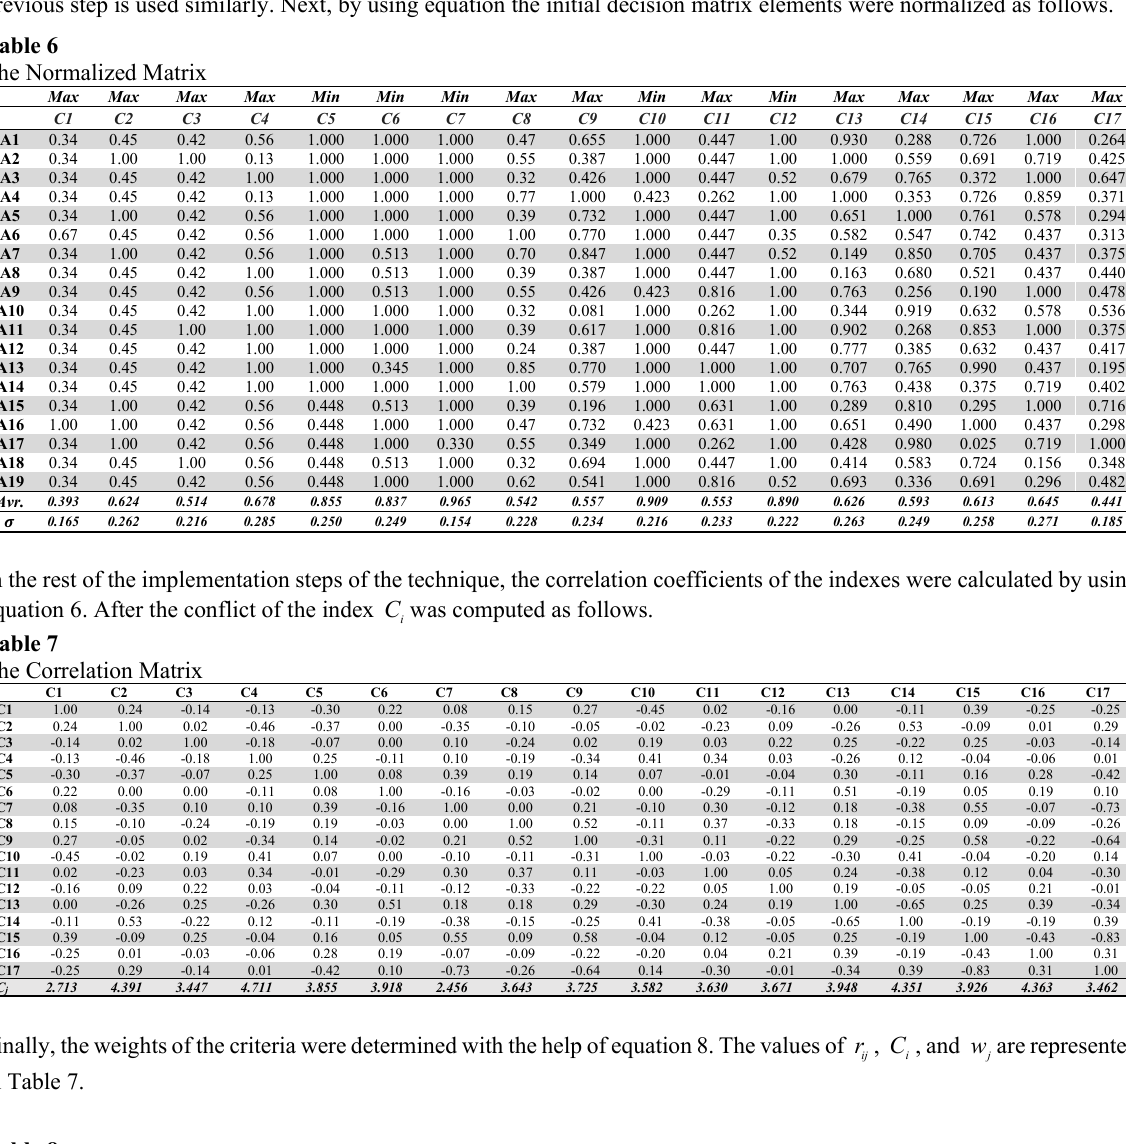
The criteria weights obtained by using the CRITIC technique